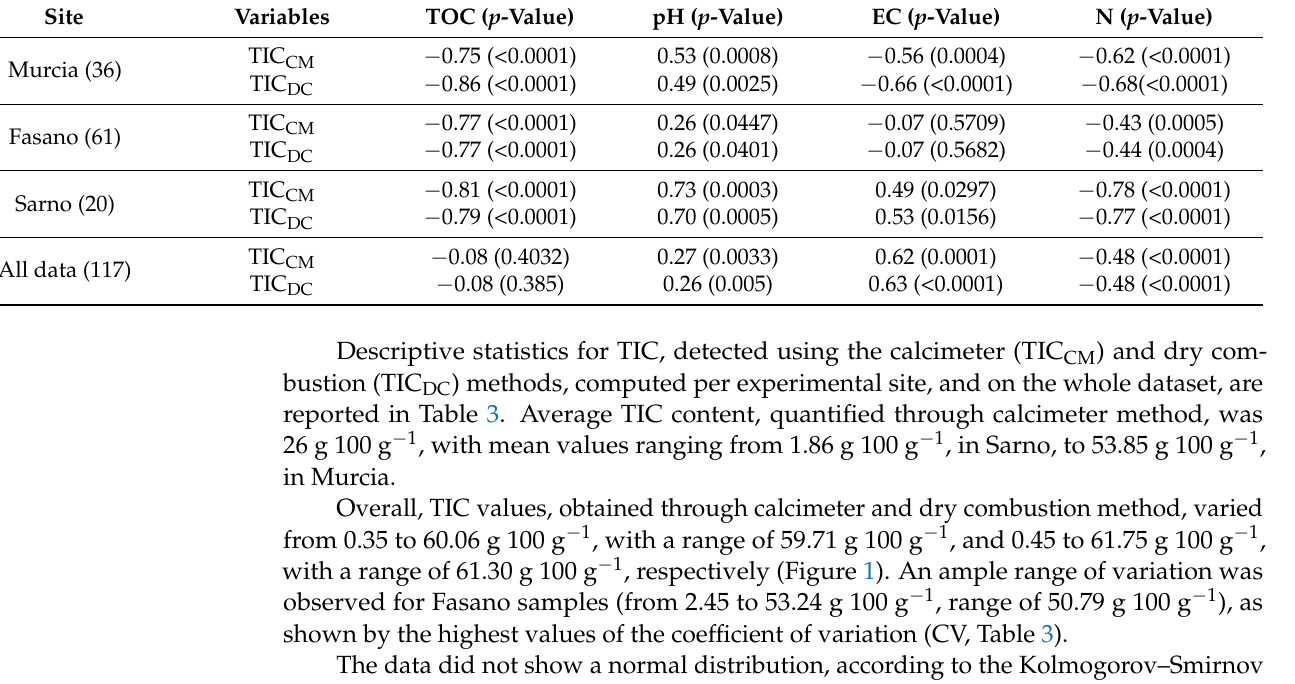
Table 2. Person’s linear coefficients (r) among total inorganic carbon quantified by calcimeter method (TIC CM ) and dry combustion method (TIC DC ) and TOC content, pH, electrical conductivity (EC), and total nitrogen content (N).